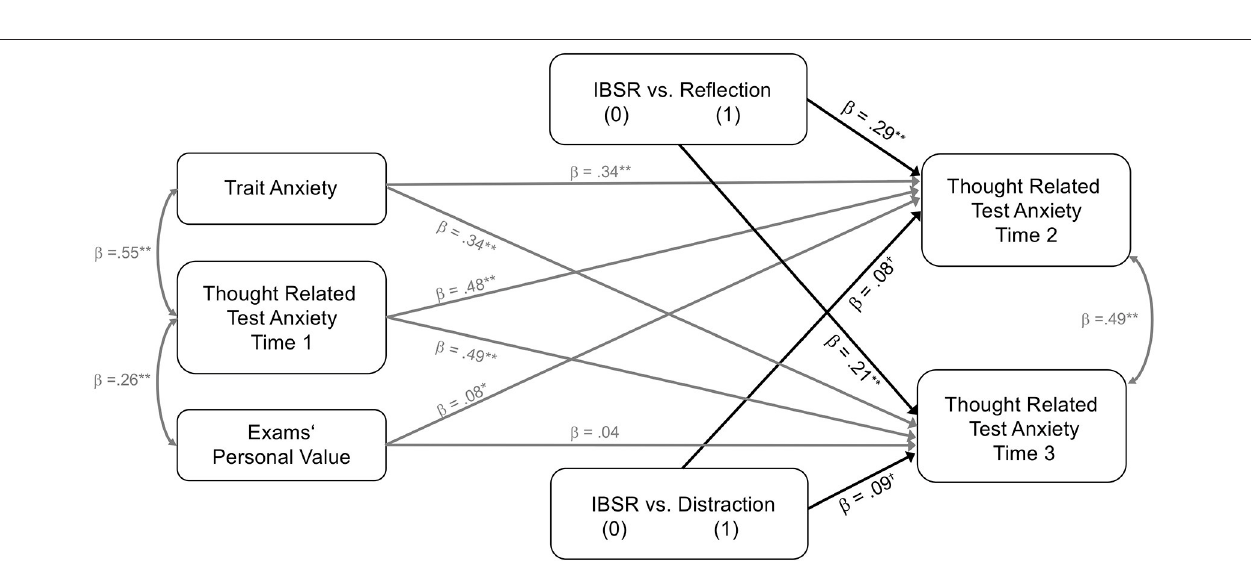
FIGURE 2 | Experimental intervention effects on targeted thought related test anxiety at times 2 and 3 while controlling for pre-intervention scores of thought related test anxiety, trait test anxiety, and exams’ personal value. IBSR vs. the reflection (IBSR dummy coded = 0, reflection dummy coded = 1, distraction dummy coded 0); IBSR vs. the distraction (IBSR dummy coded = 0, reflection dummy coded = 0, distraction dummy coded 1). All parameter estimates are standardized. N = 160. † p ≤ 0.10, * p ≤ 0.05, ** p ≤